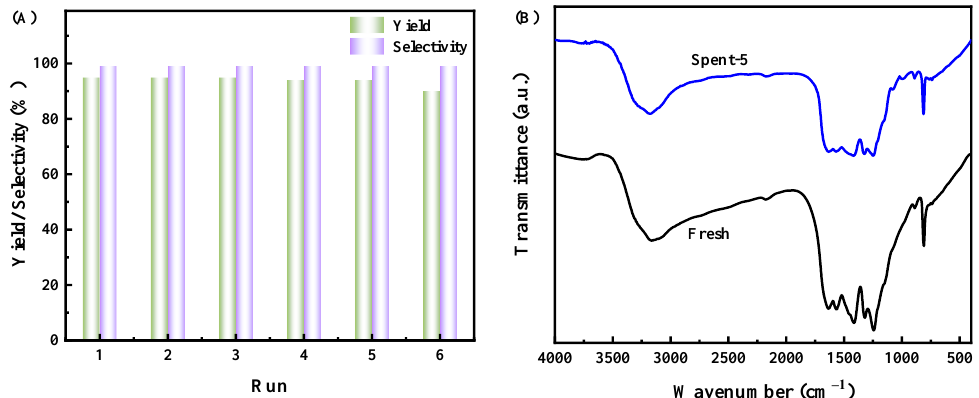
Figure 7. ( A ) Recyclability of BP-CN-1, conditions: PO 34.5 mmol, 100 mg BP-CN-1, 100 mg Bu 4 NBr, 120 °C, CO 2 2.0 MPa, 6 h; ( B ) FT-IR spectra of BP-CN-1 and reused BP-CN-1.